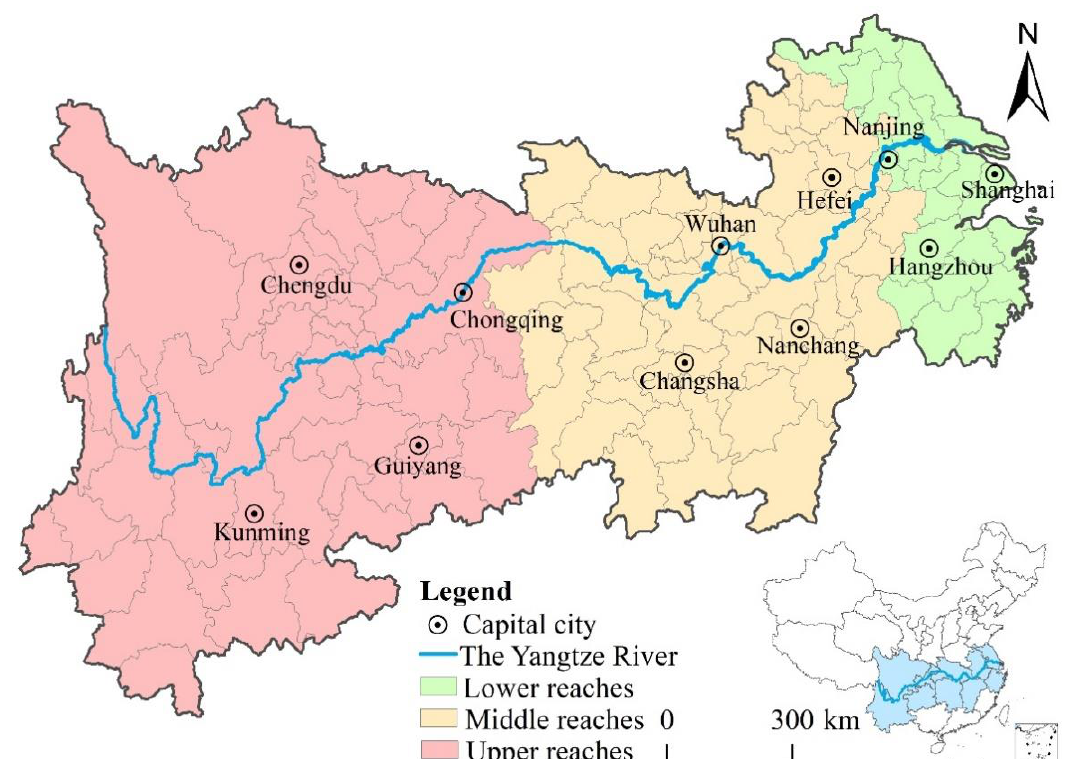
Figure 2. Location of the Yangtze River Economic Belt in China.